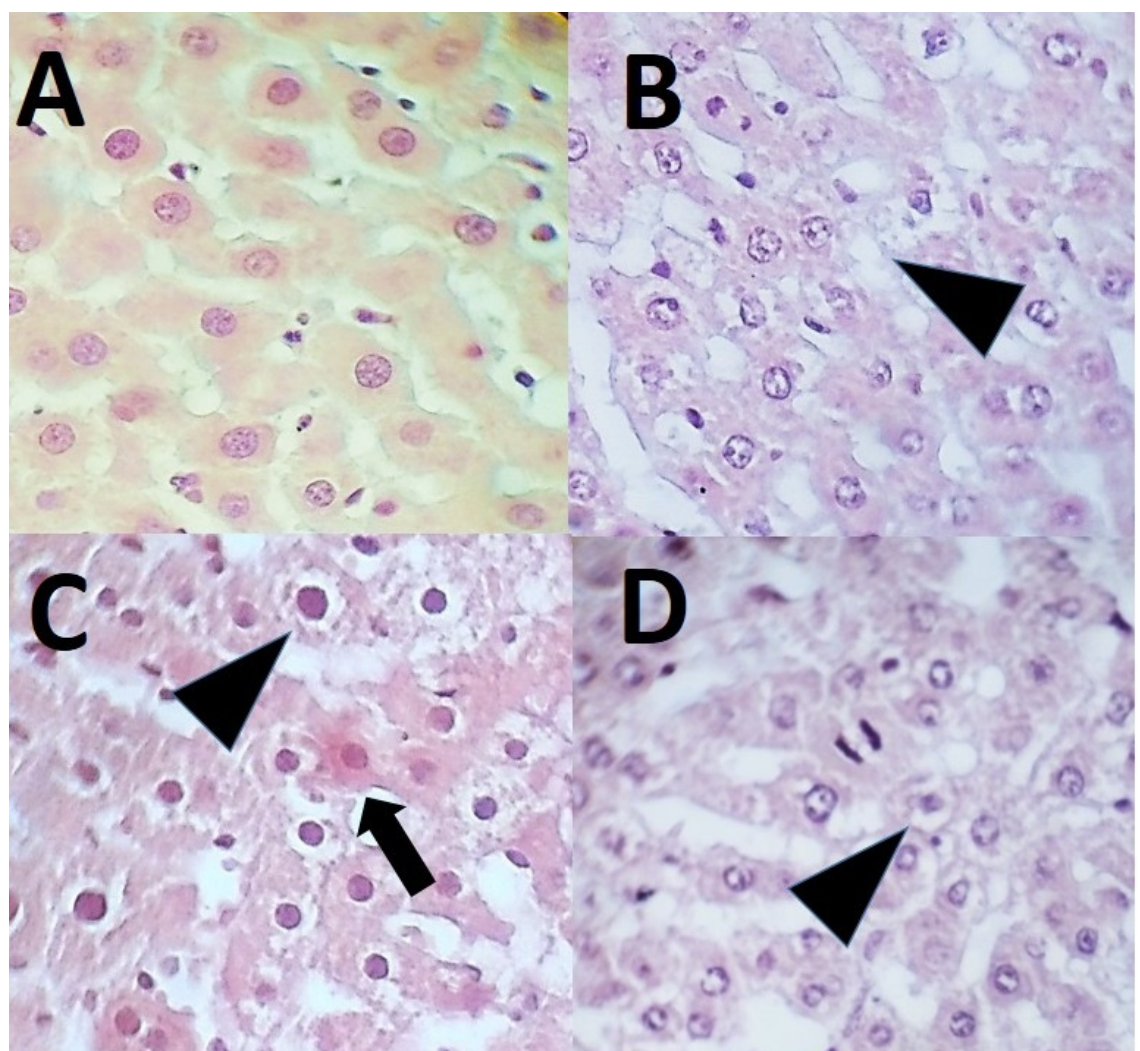
Figure 7. ( A ) Periodic acid-Schiff (PAS) section liver section of a control rat showing liver morphology with normal hepatocytes and hepatic cords. ( B ) The liver section of a rat received the 30 mg/kg dose of curcumin microemulsions, showing normal hepatocytes and hepatic cords, indicating normal histology of the liver. ( C ) liver sections of a thioacetamide-intoxicated rat, intra-cytoplasmic fat vacuoles are observed (arrow); ( D ) liver section of a thioacetamide-intoxicated rat treated with intraperitoneal injections of 30 mg/kg curcumin microemulsions, showing a decrease in fatty change (arrow point). Periodic acid–Schiff (PAS) staining (40× magnification).